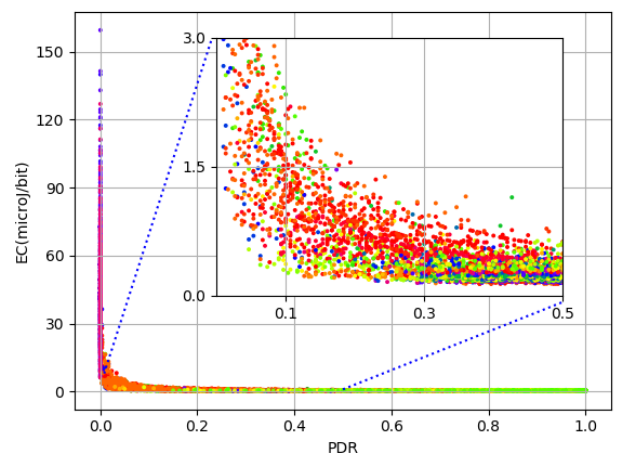
Figure 2. Relationship between PDR and EC .